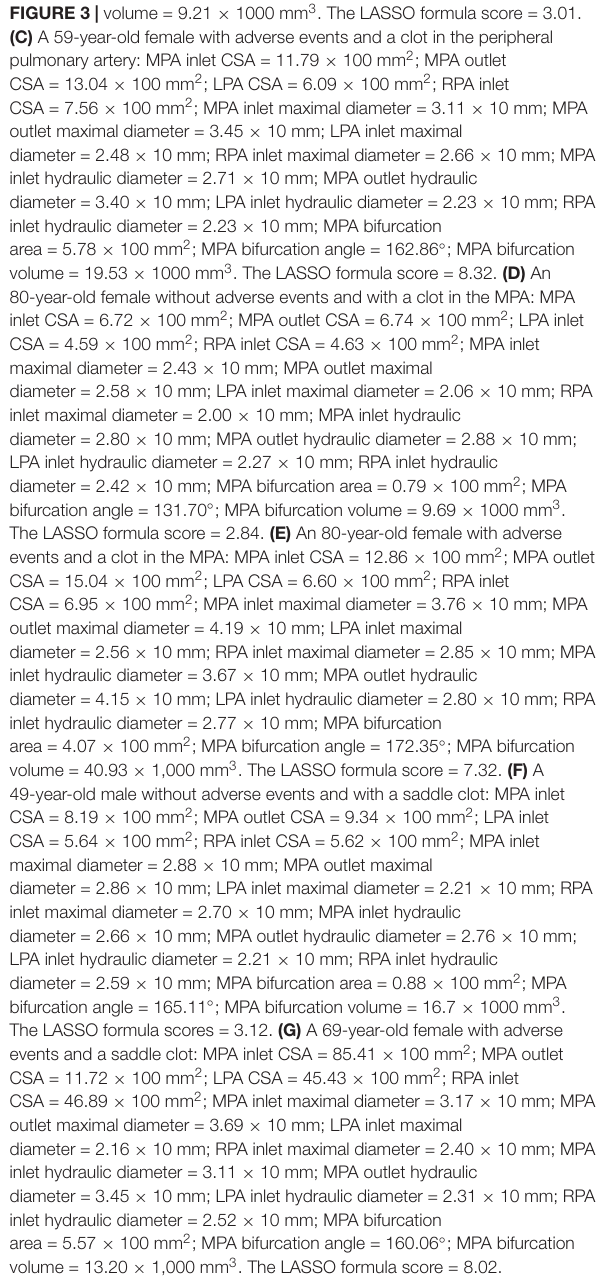
FIGURE 3 | volume = 9.21 × 1000 mm 3 . The LASSO formula score = 3.01. (C) A 59-year-old female with adverse events and a clot in the peripheral pulmonary artery: MPA inlet CSA = 11.79 × 100 mm 2 ; MPA outlet CSA = 13.04 × 100 mm 2 ; LPA CSA = 6.09 × 100 mm 2 ; RPA